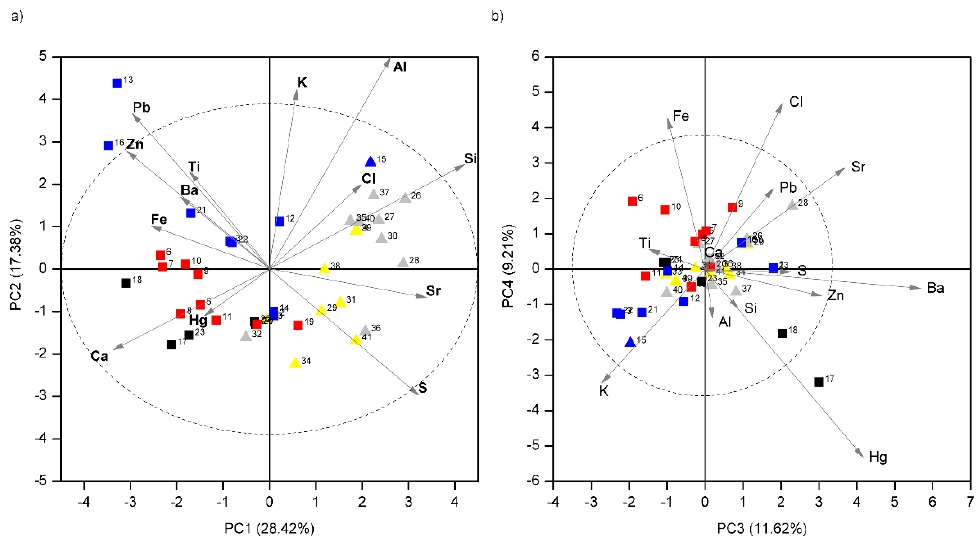
Figure 2. PCA results on XRF data. Biplots of scores and loadings for ( a ) PC1 versus PC2 and ( b ) PC3 versus PC4. Measurement points (scores) are labeled according to the color of the visual inspection and the support. Labelling: blue ( ■ ), red ( ■ ), and black ( ■ ) motifs in the socles; plasterwork substrate ( ▲ ) and white finishing layer ( ▲ ) in plasterwork.